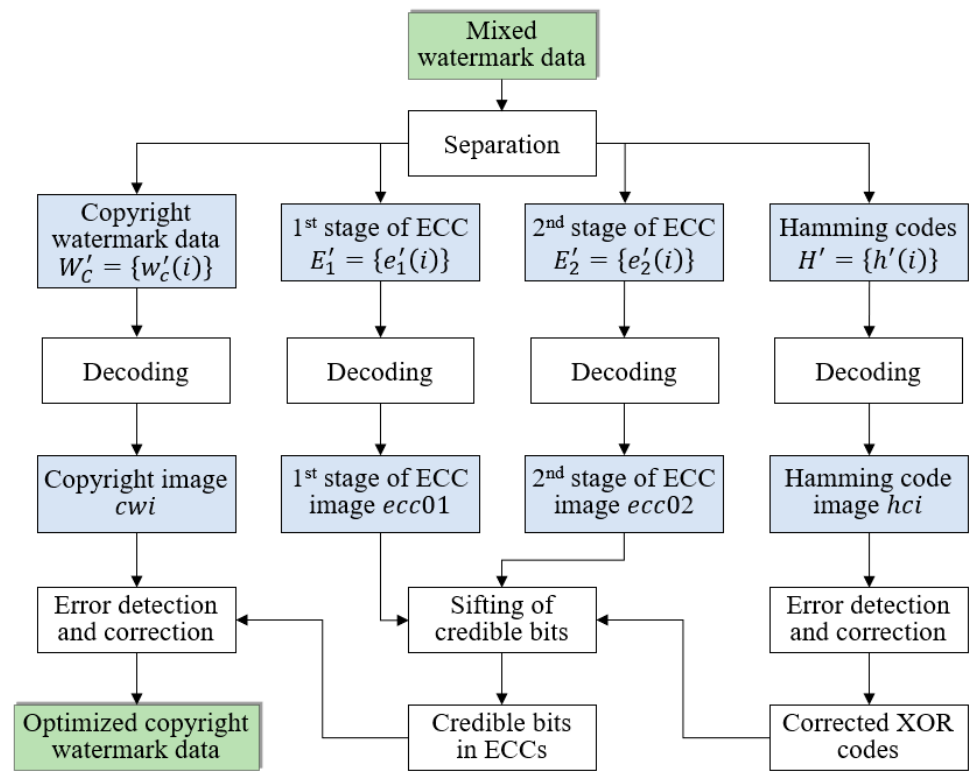
Figure 8. Diagram of self-optimization of the extracted mixed watermark data.